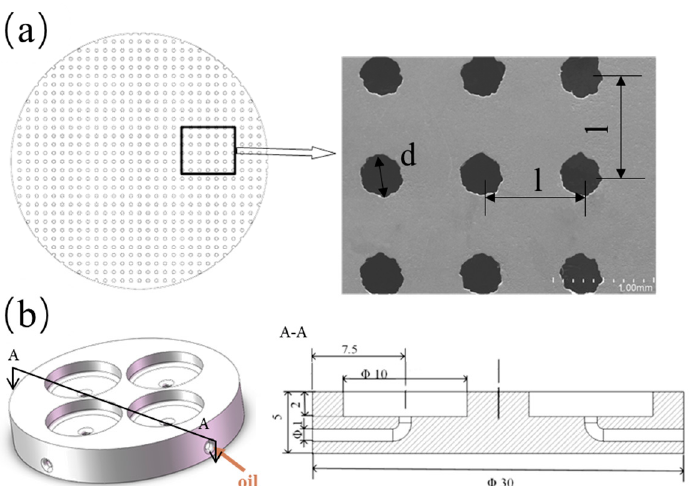
Figure 2. ( a ) Schematic diagram of the textured surface and the SEM of the textured surface; ( b ) model of the pocket substrate (the unit labeled is in the model of the pocket substrate (the unit labeled is in mm).